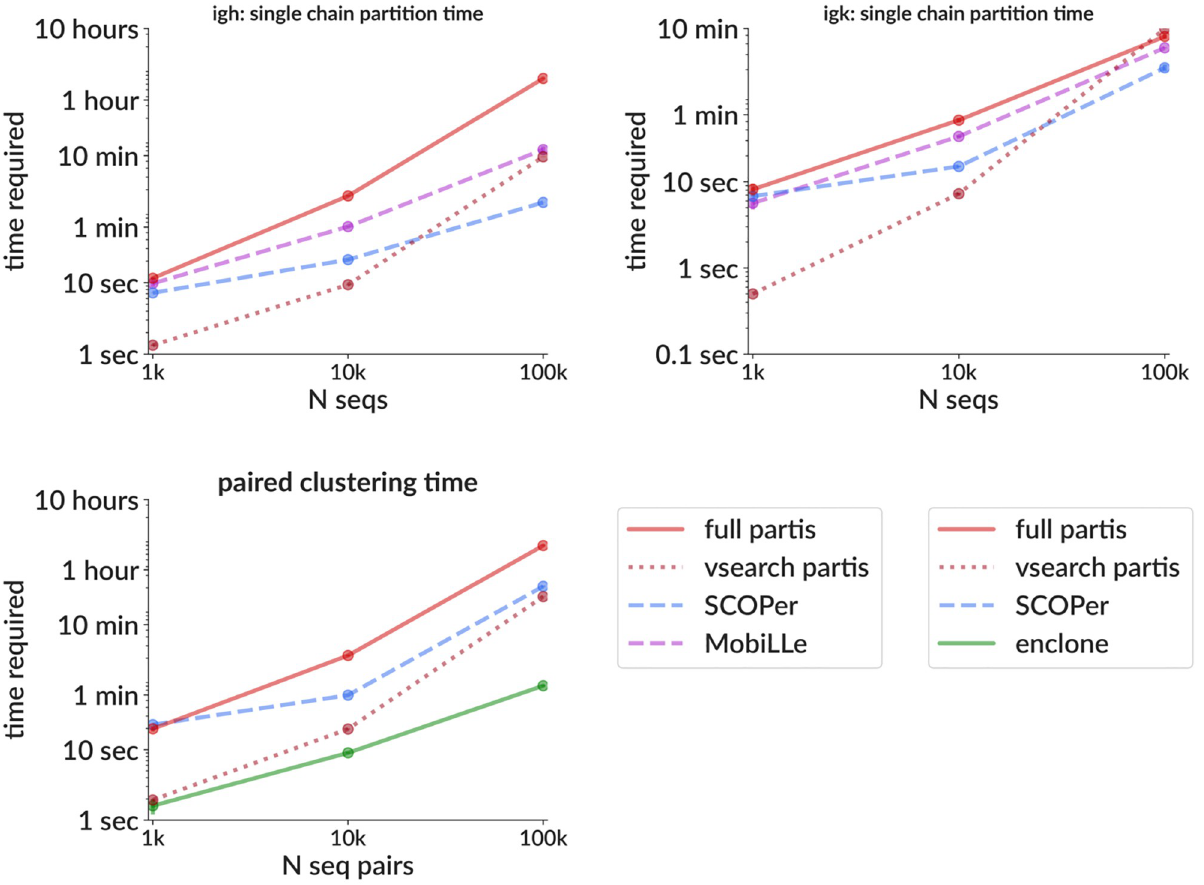
Fig 6. Time required for clustering for a variety of methods for both single chain clustering (top, for IgH [left] and IgK [right]) and paired clustering (including single chain clustering, bottom left). Note that for partis the actual paired clustering takes only around five minutes on the 100k samples, so for partis the bottom plot time is roughly equal to the sum of the top two plots (at the moment the single chain clustering for heavy and light are not run concurrently). Each point is the mean ( ± standard error, often smaller than points) over two samples with the indicated size, run on a single desktop with a 14-core Intel i-99940X processor and 128GB memory (maximum memory usage for partis on the 100k samples was around 9GB). The size of each family is drawn from a geometric distribution with mean 10. Note that because enclone by design discards sequences with high SHM, here it is clustering only the ’ 80% of sequences that it